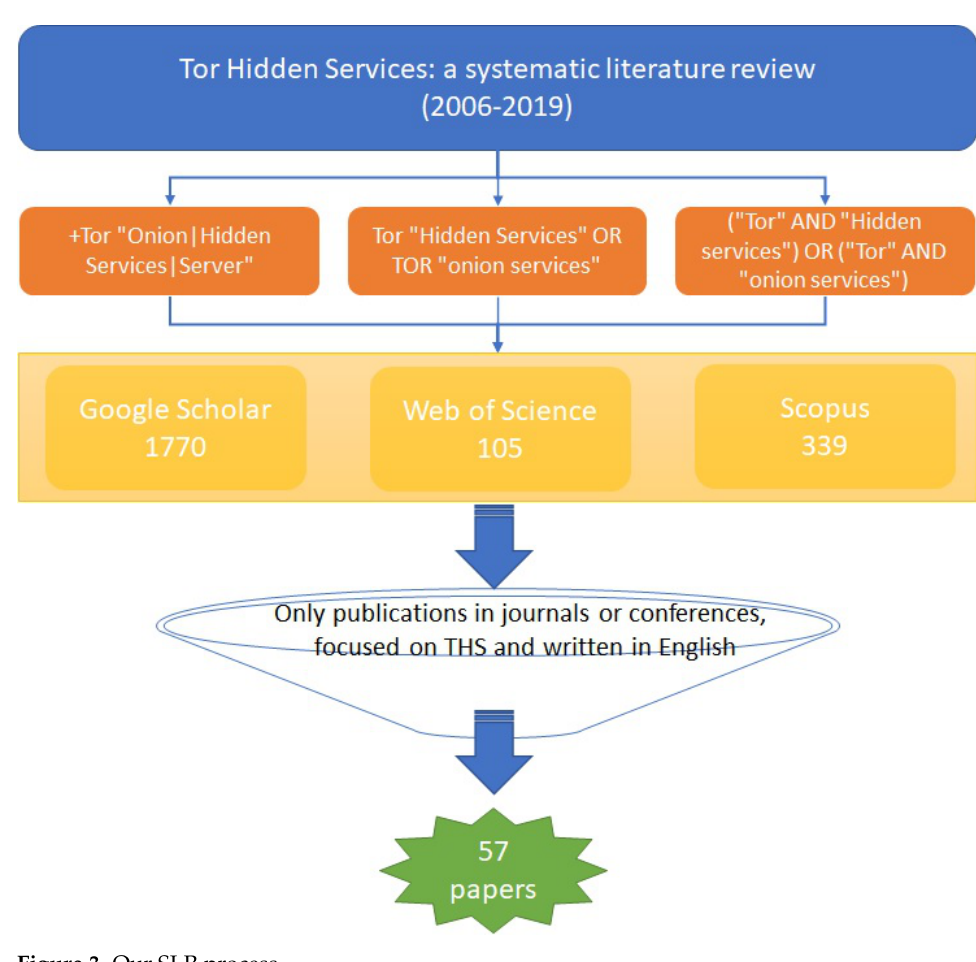
Figure 3. Our SLR process.